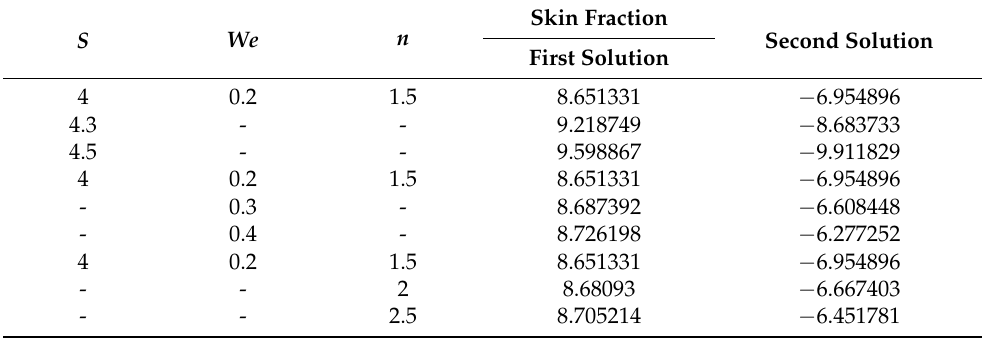
Table 1. Numerical results of local skin friction coefficient for various values of A = 0.1, Ec = 1, and Pr = 1.